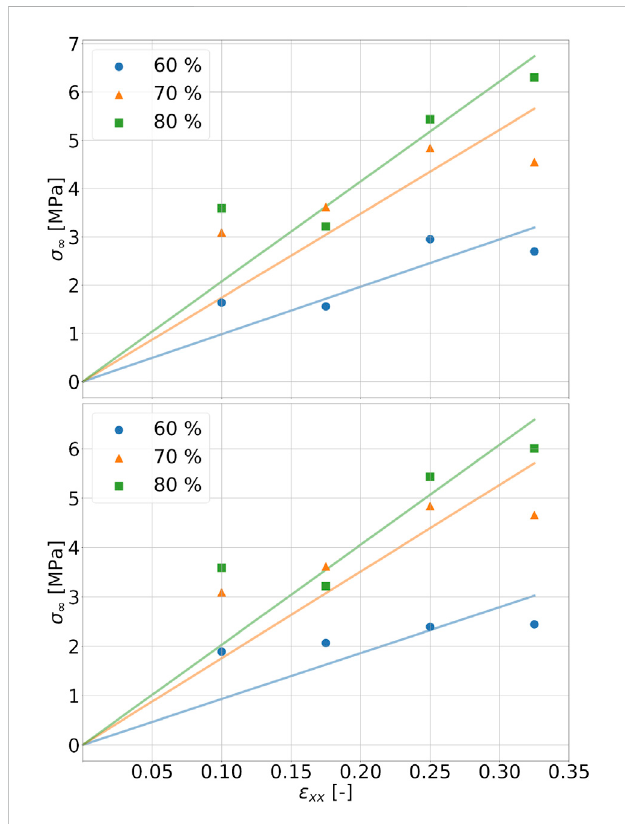
FIGURE 7 Linearregressionofrelaxedstressesindependencyof fi nalstrainof tension tests for strain rate of 10 7 1/ s . The ratio of polymer chain to linker is 2 to 1 in the top fi gure and 5 to 3 in the bottom fi